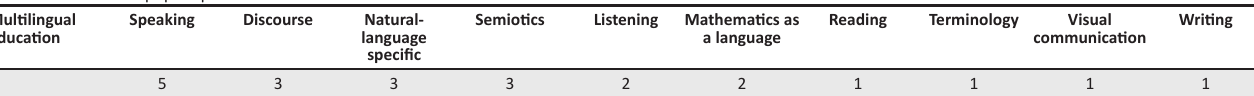
TABLE 3: Number of papers per area of